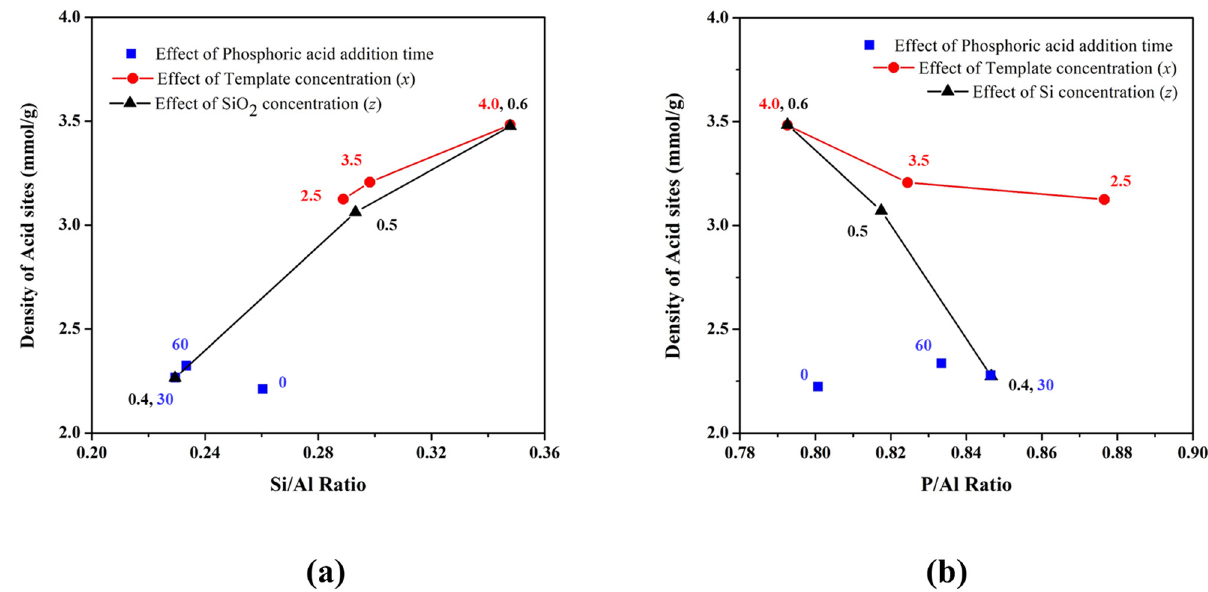
Figure 11. The effect on the density of acid sites with the variation of ( a ) Si/Al ratio and ( b ) P/Al ratio in the SAPO-34 particles synthesized under different variations.